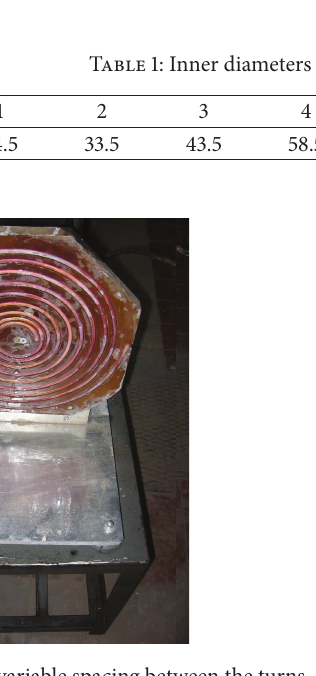
Figure 6: Flat inductor with variable spacing between the turns.